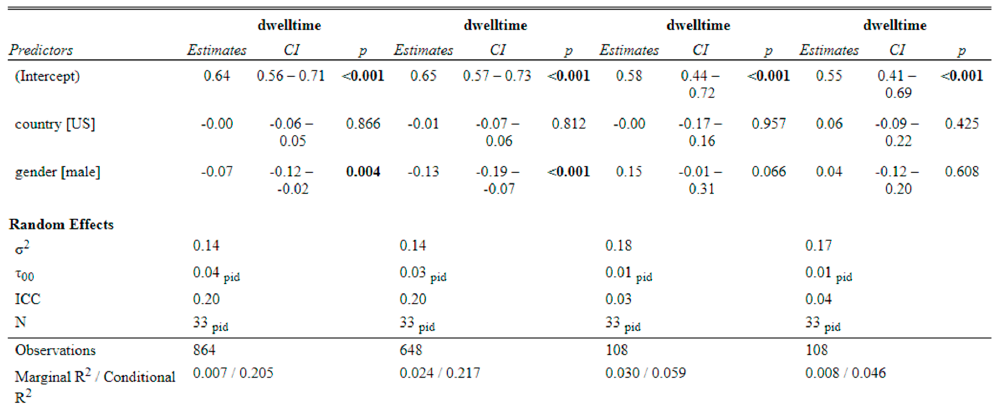
Figure 6. Output from the linear mixed effects model from the models m0–m3 (left to